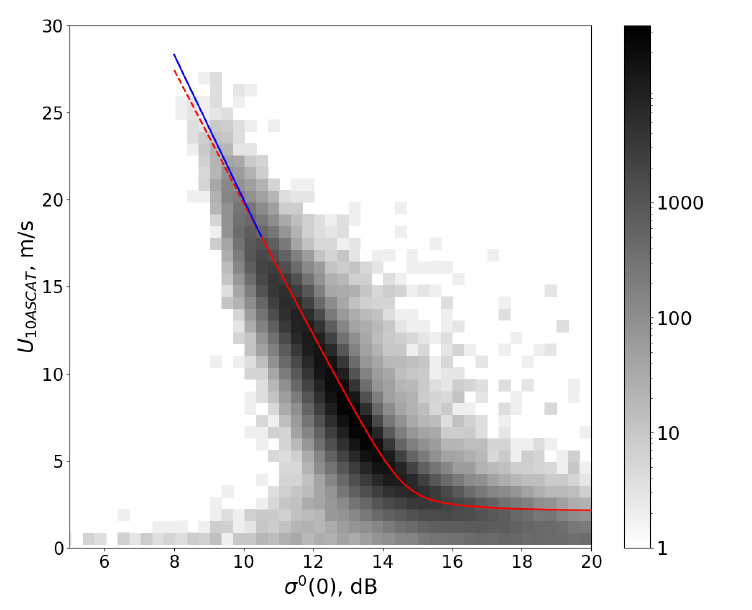
Figure 5. Histogram of wind speed dependence on NRCS. The red line represents the dependence (8) extrapolated to high winds (dashed part). The blue line represents the dependence (7).